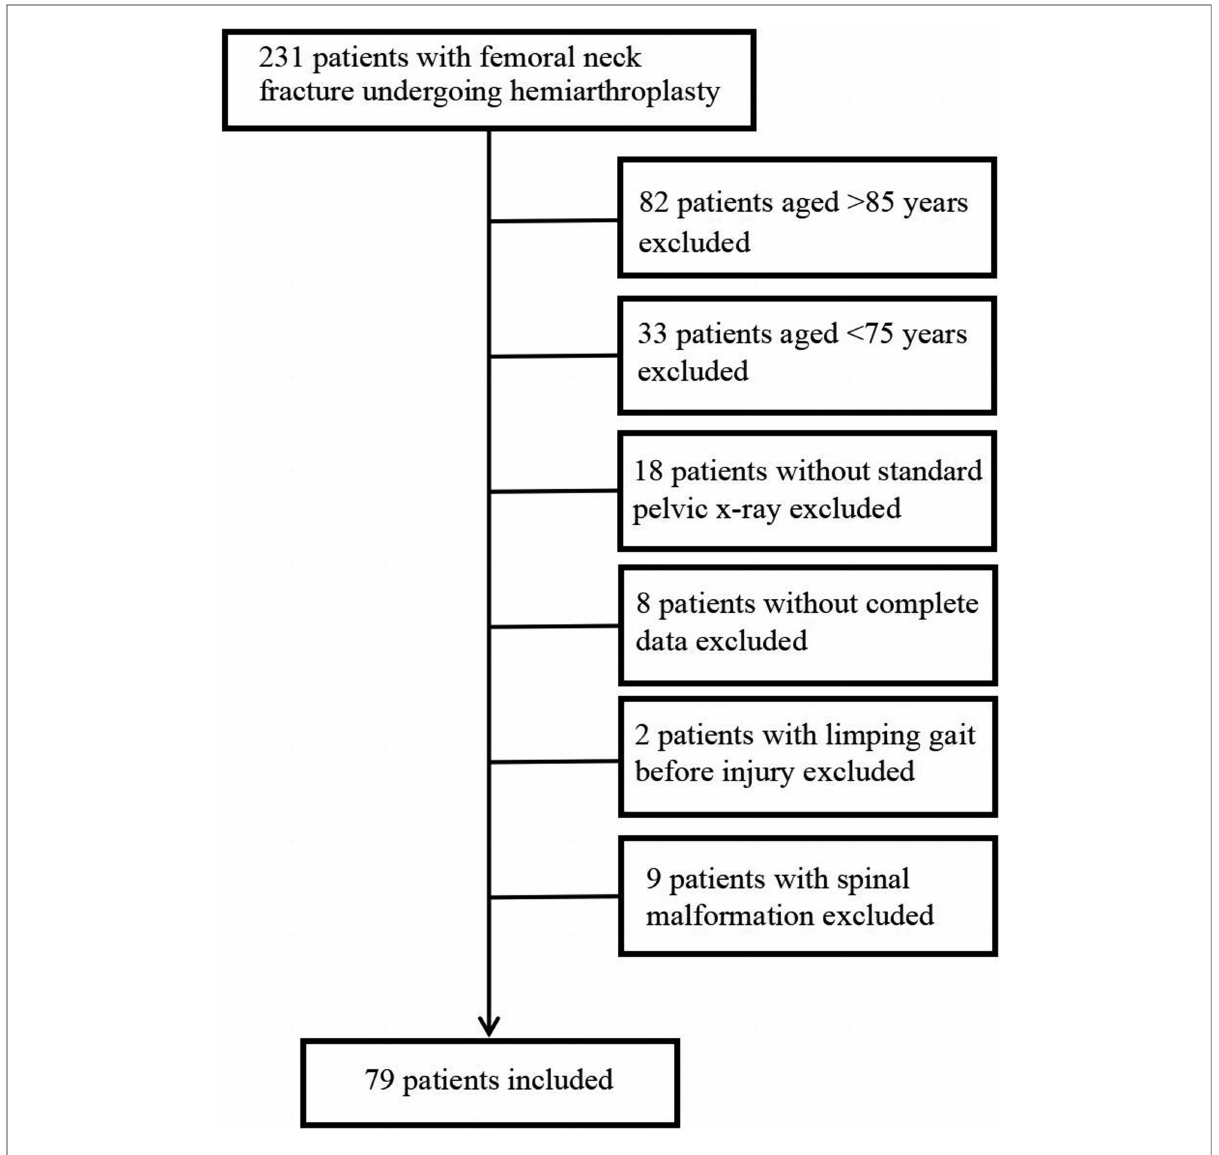
FIGURE 1 Flowchart demonstrating patient inclusion in the